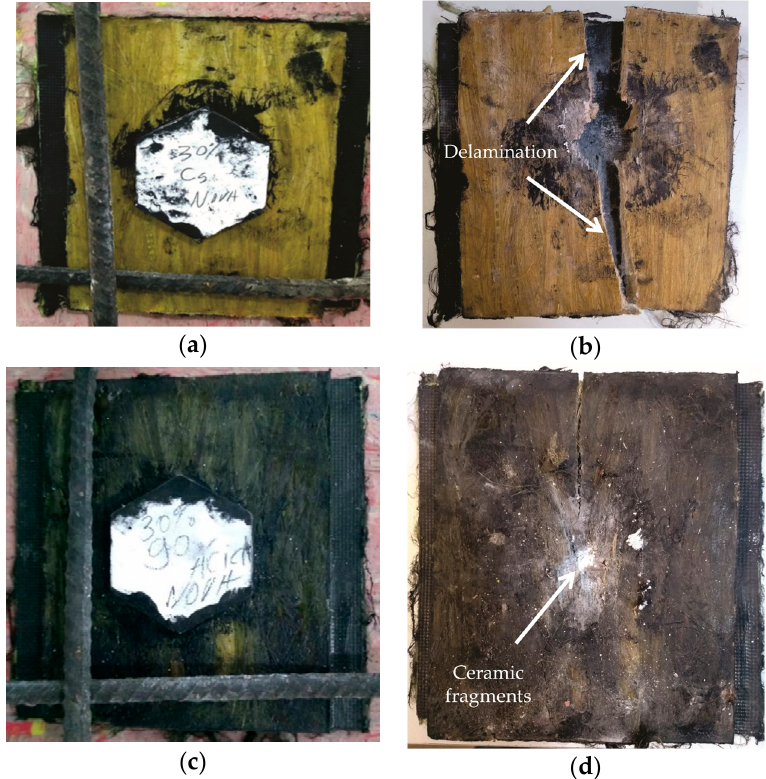
Figure 13. View of MAS target before ( a , c ) and after ( b , d ) the ballistic test: with second layer of ( a , b )